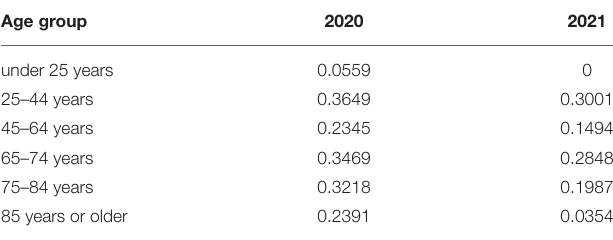
TABLE 1 | Excess death rate for each age group in 2020 and 2021. Age group